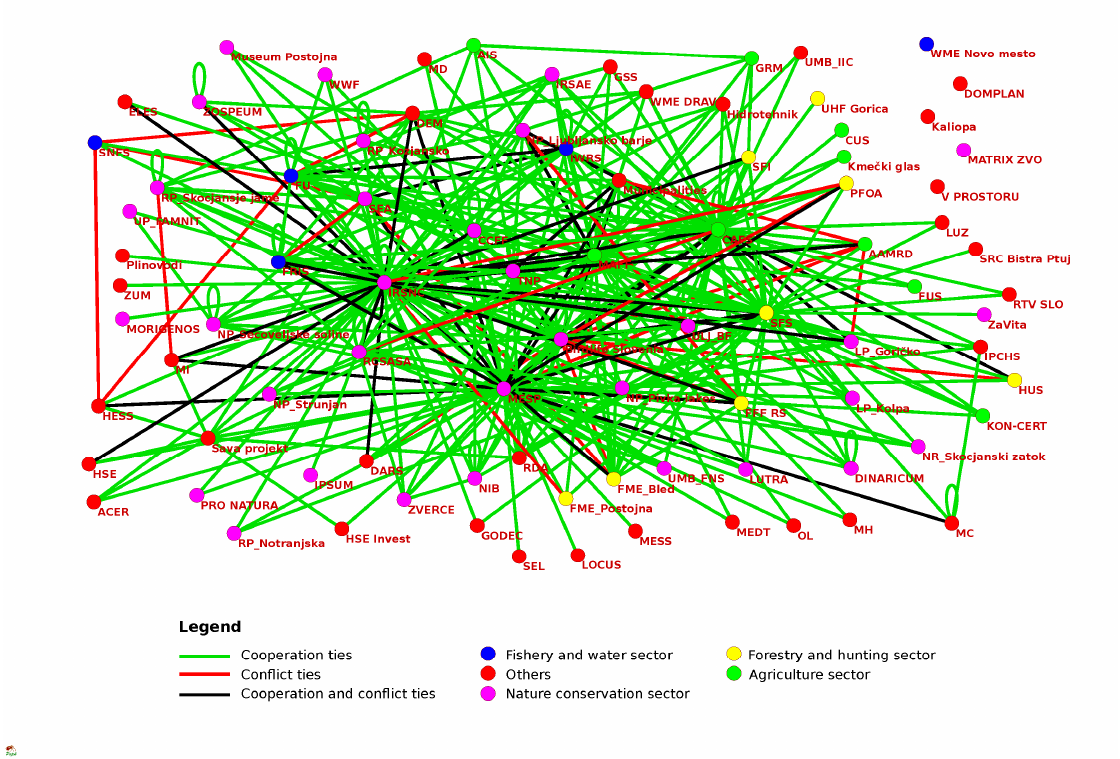
Figure 1. Cooperation and conflict network of the institutions in participatory process of formulation of Natura 2000 Management programme in Slovenia for the period 2015–2020 (print in colour)